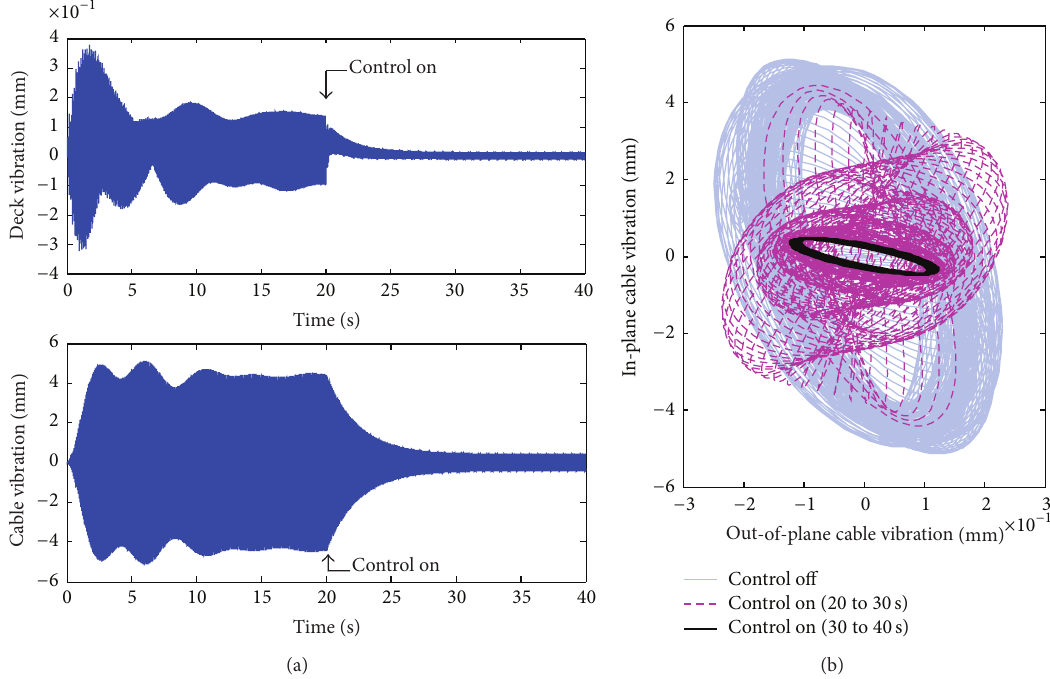
Figure 13: (a) Evolution in time of the vertical deck vibration and the in-plane cable vibration at L /2 (control on at 20 s); (b) cable trajectory at L /2 before and after control (case of fundamental parametric